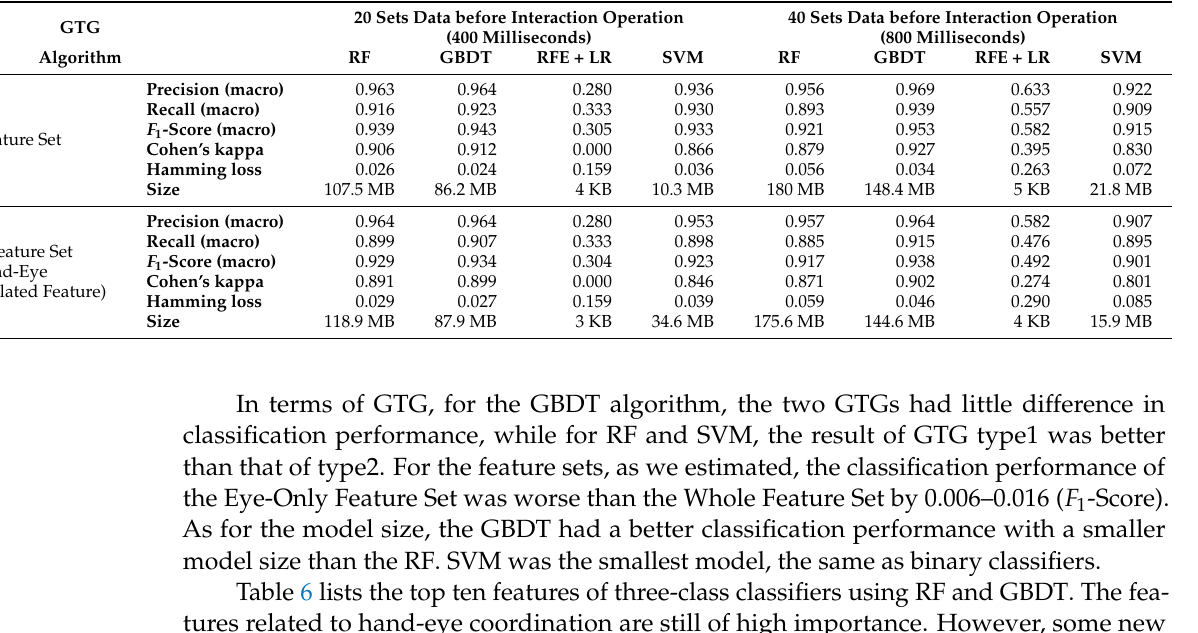
Table 5. Three-class classification results for the combinations of four classifiers (RF, GBDT, LR, and SVM), two feature sets, and two GTG methods. 20 Sets Data before Interaction Operation 40 Sets Data before Interaction Operation GTG (400 Milliseconds) (800